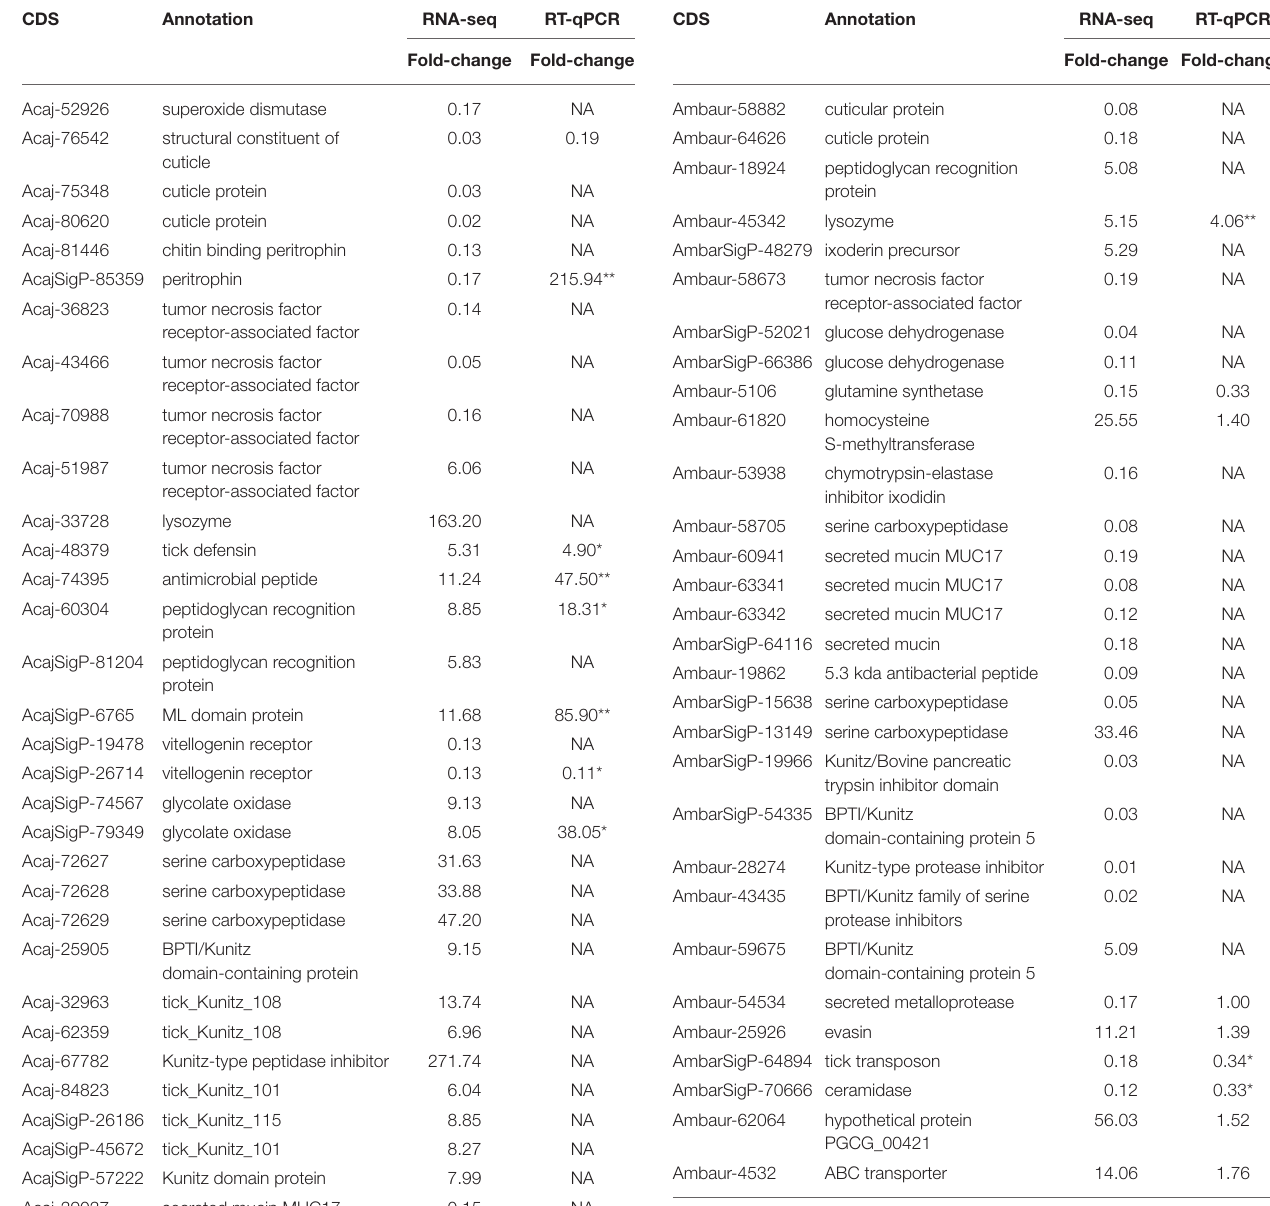
TABLE 2 | Selected CDSs of A. sculptum midgut differentially expressed by infection with R. rickettsii . CDS